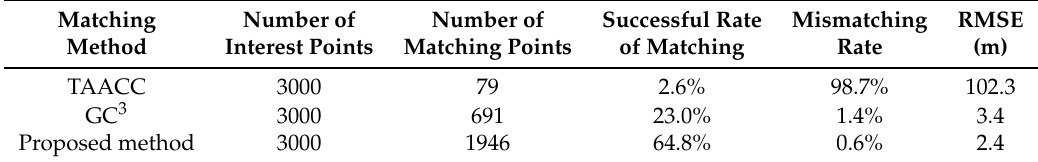
Table 2. Experimental results produced by TAACC, GC 3 and the proposed method.